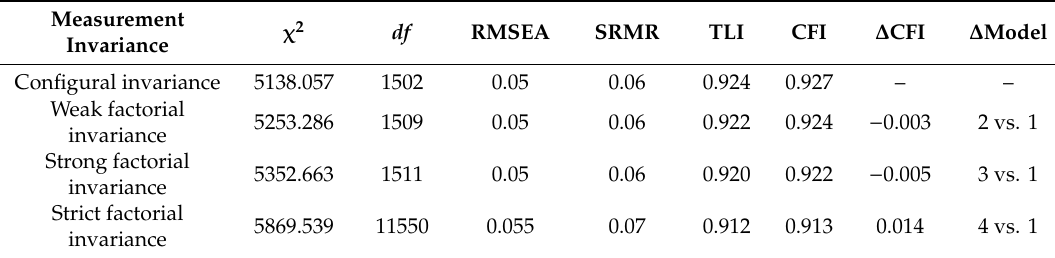
Table 2. Measurement invariance analysis to ensure that the target items measure the same theoretical constructs (latent variables or factors) in all